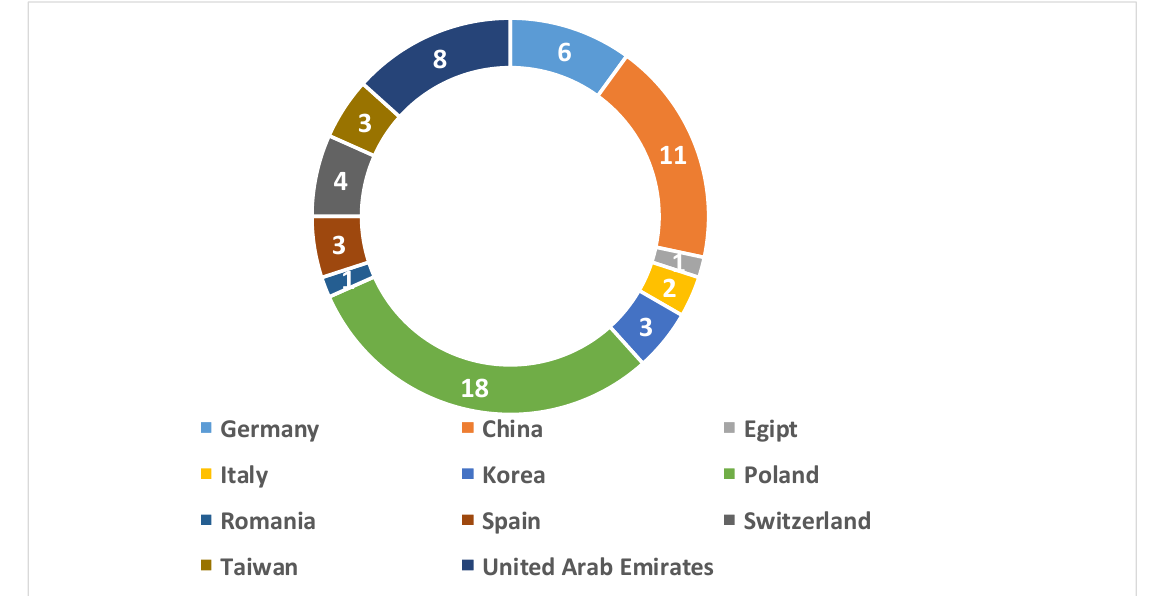
Figure 1. Distribution of authors by countries.